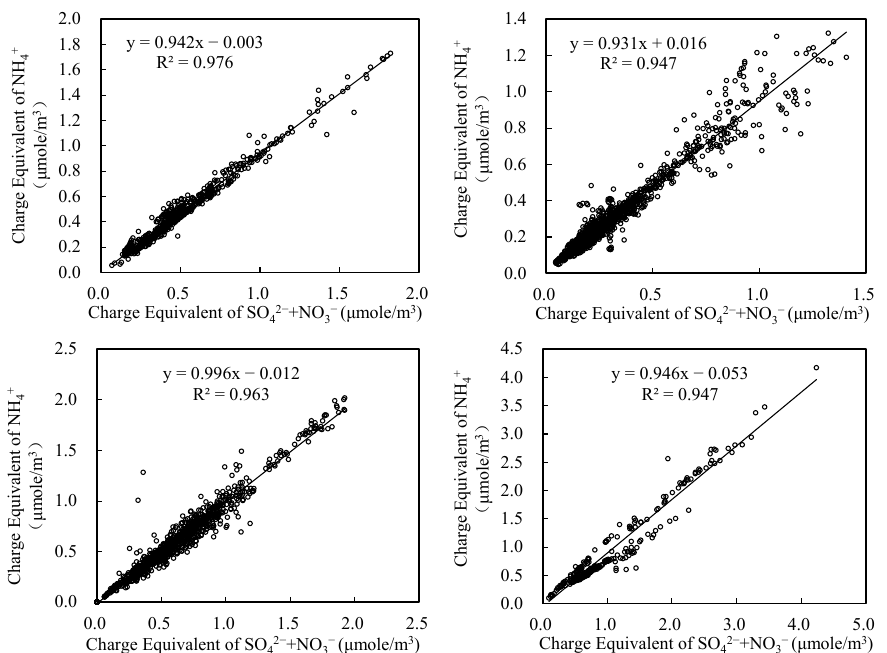
Figure 6. Positive and negative charge balances of NH 4+ , SO 42− and NO 3− in all four seasons in Wuhan. Synthetically, diverse forms of inorganic water-soluble ions in PM 2.5 not only have some similar states or common characteristics but also exists some variation in four different seasons in Wuhan.